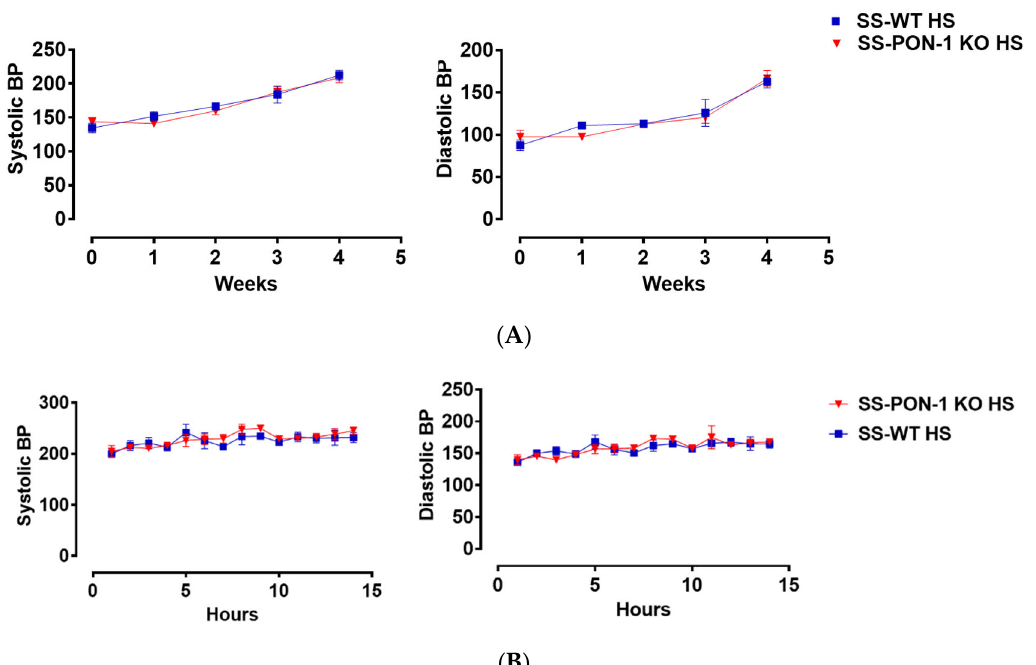
Figure 7. Targeted mutation of paraoxonases ‐ 1 shows no effect on blood pressure in the SS_PON ‐ 1 KO compared to SS rats after a high ‐ salt diet. ( A ) Systolic (left) and diastolic (right) blood pressure assessed by tail cuff plethysmography (N = 8/group) over 4 weeks ( B ) Systolic (left) and diastolic (right) blood pressure assessed by radiotelemetry at 4 weeks (N = 4/group). SS ‐ PON ‐ 1 KO rats show similar increase in blood pressure, compared to SS rats following 5 weeks 8% high ‐ salt diet.